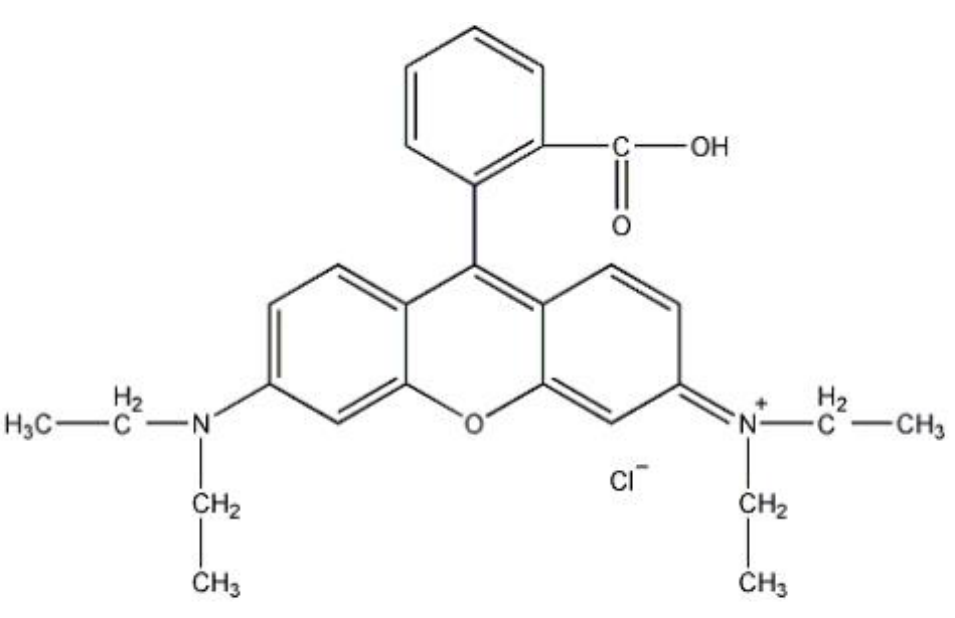
Figure 1. Molecular structural models of RhB.